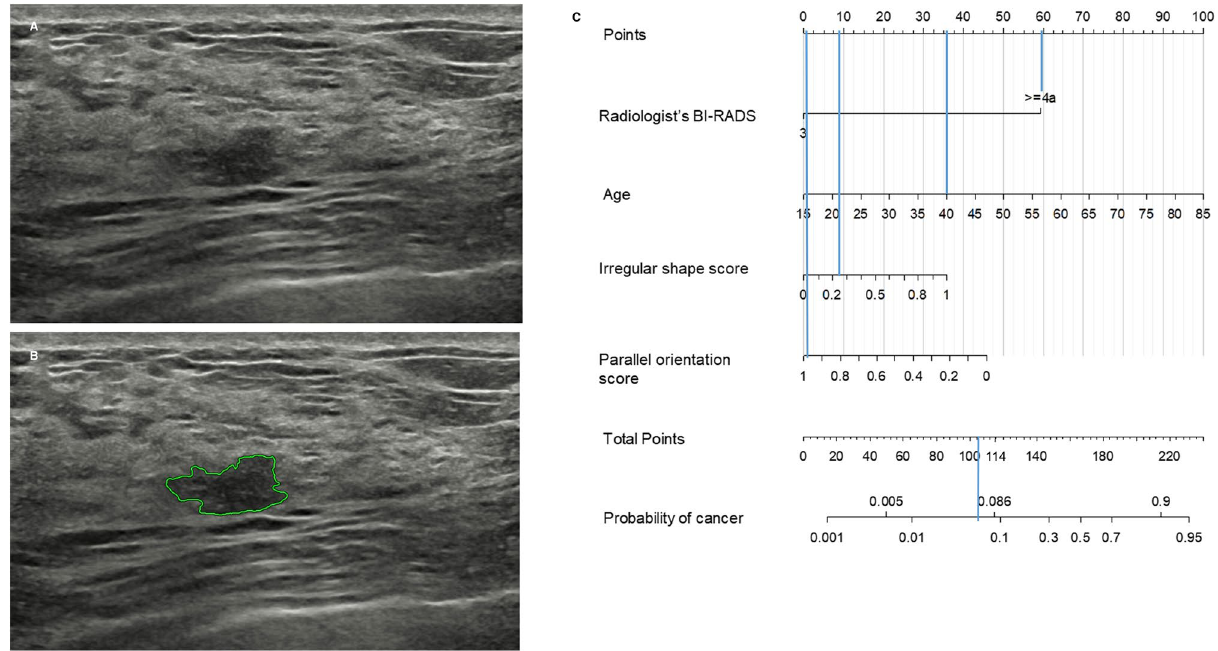
Figure 2. Benign breast mass correctly classified by the nomogram. ( a ) A 40-year-old woman in the validation cohort had a 1.0-cm breast mass detected by screening US. This mass assessed as Breast Imaging Reporting and Data System (BI-RADS) 4A by a radiologist was subject to US-guided 14-gauge core needle biopsy. The biopsy result was fibrocystic change and the mass was stable on 12 months follow-up US. ( b ) The deep learning based computer-aided diagnosis software assigned an irregular shape score of 0.25 and parallel orientation score of 0.98. ( c ) This mass has 105 points on the nomogram, which was lower than the cut-off of 114. A false-positive biopsy could be omitted safely if the nomogram was